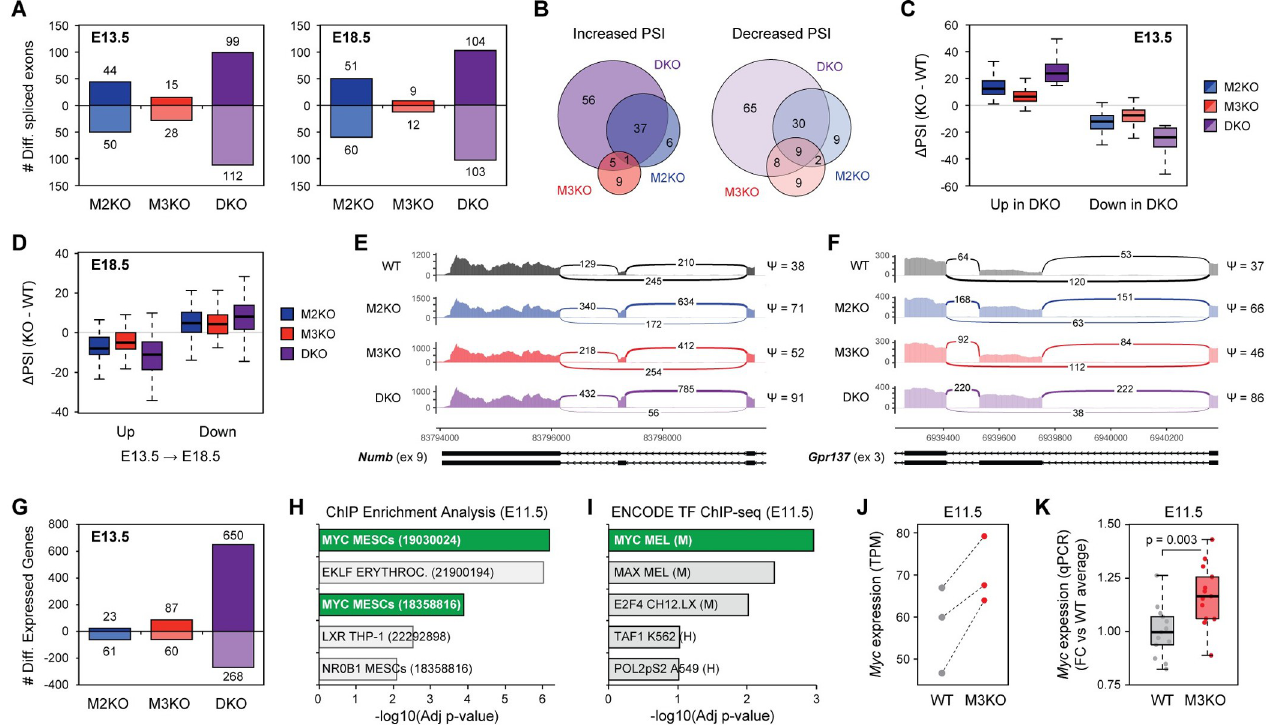
Fig 4. Effect of Mbnl2 , Mbnl3 , and double Mbnl2/3 KO on the placental transcriptome. (A) Bar charts showing the number of differentially spliced exons in M2KO, M3KO, and DKO placentas at the indicated embryonic stages. Exons with increased inclusion in KOs are tallied above the x-axis, while exons with reduced inclusion are tallied below. (B) Venn diagrams showing the overlap in differential spliced exons between M2KO, M3KO, and DKO placentas at E13.5. (C) Boxplots showing the difference in exon inclusion (PSI) in the indicated KOs versus WT placentas for all exons differentially spliced in DKOs versus WTs at E13.5. (D) Boxplots showing the change in PSI in the indicated KO versus WT placentas at E18.5 for all exons with differential inclusion between E13.5 and E18.5 WT placenta. (E, F) Sashimi plots showing usage of Numb exon 9 (E) and Gpr137 exon 3 (F) in placentas with the indicated genotypes at E13.5. The PSI values for the exons in the different genotypes are shown to the right of the plots. (G) Bar charts showing the number of differentially expressed genes in M2KO, M3KO, and DKO placentas at E13.5. Genes with increased expression in KOs are tallied above the x-axis, while genes with reduced expression are tallied below. (H, I) Bar charts showing significance levels for enrichment of TF binding sites among genes up-regulated in M3KO placentas at E11.5. The top 5 most significantly enriched TFs are shown for ChEA (H) and ENCODE (I) data sets. (J, K) Plots showing Myc expression levels in WT and M3KO placentas at E11.5 based on RNA-seq (J) and qPCR (K). In (J), matched placenta pools derived from the same litters are indicated by dashed lines. For (K), values correspond to the fold change between each tested placenta and the average of WT placenta; N = 13 placentas for each genotype. Significance levels were calculated by Wilcoxon rank-sum tests. The numerical data underlying this figure can be found in S1 Data. DKO, double knockout; KO, knockout; MBNL, Muscleblind-like; M2KO, Mbnl2 knockout; M3KO, Mbnl3 knockout; PSI, percentage spliced in; qPCR, quantitative real-time PCR; RNA-seq, RNA sequencing; TF, transcription factor; WT,